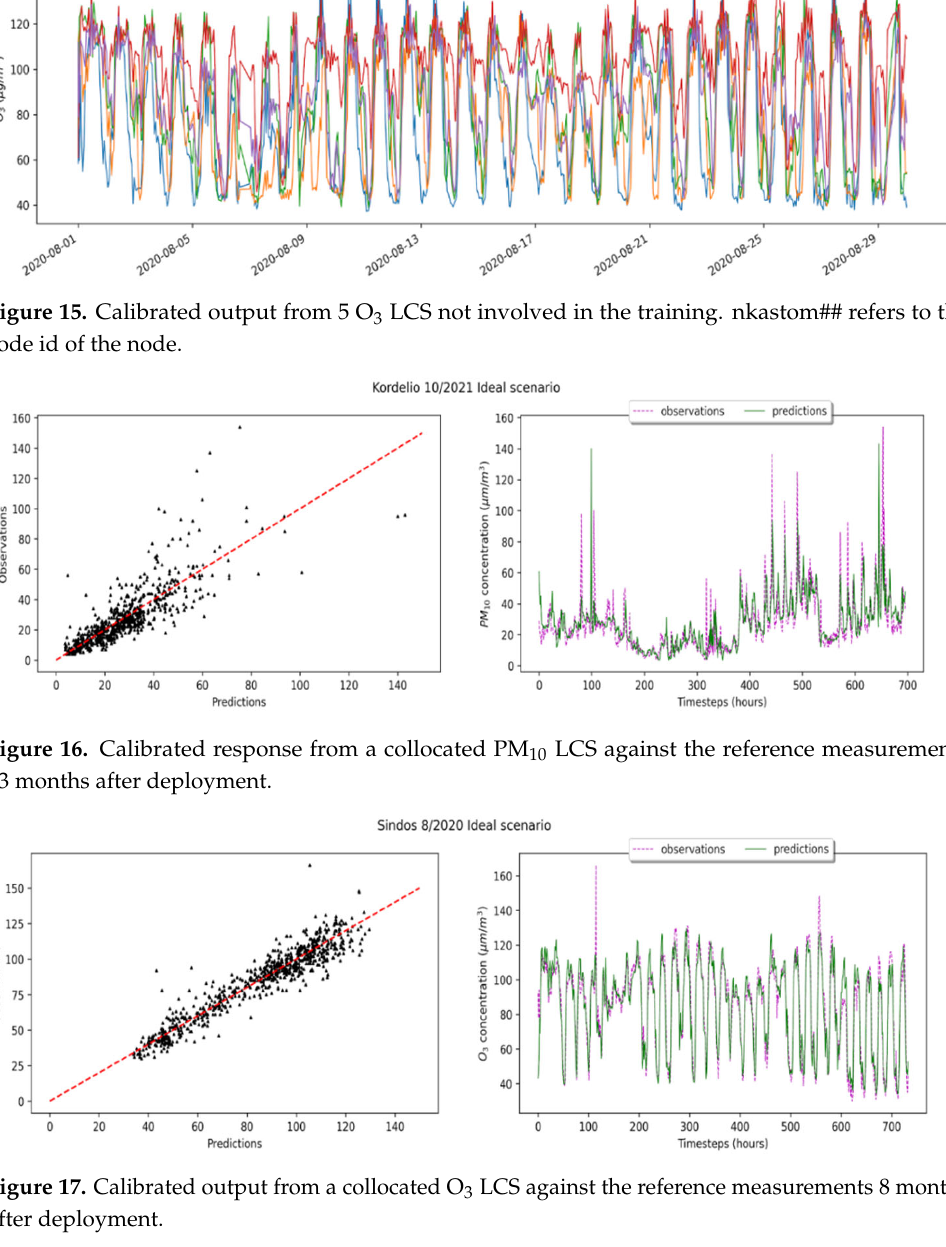
Figure 17. Calibrated output from a collocated O 3 LCS against the reference measurements 8 months after deployment.